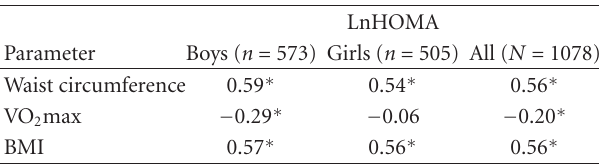
Table 2: Pearson product moment correlation coe ffi cients between waist circumference, VO 2 max, BMI, and lnHOMA by